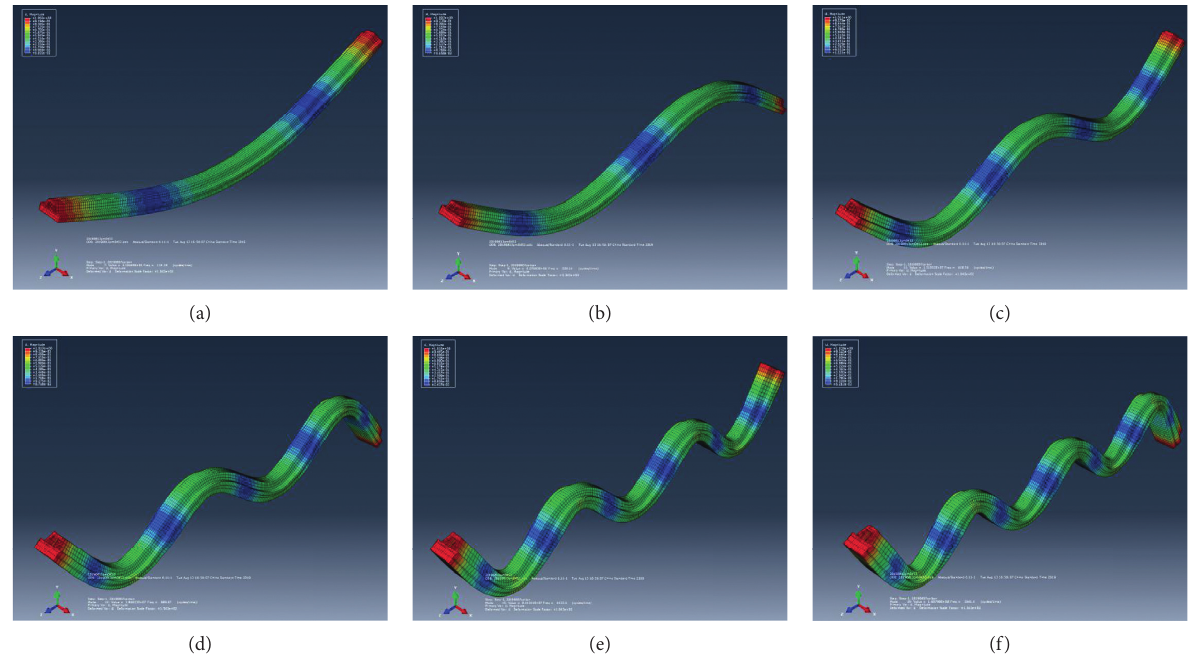
Figure 3: Mode shapes and modal frequencies of the first six vertical modes. (a) Mode 1,65.86Hz. (b) Mode 2,139.81Hz. (c) Mode 3,241.57 Hz. (d) Mode 4,389.10Hz. (e) Mode 5,588.94Hz. (f) Mode 6,810.66 Hz.